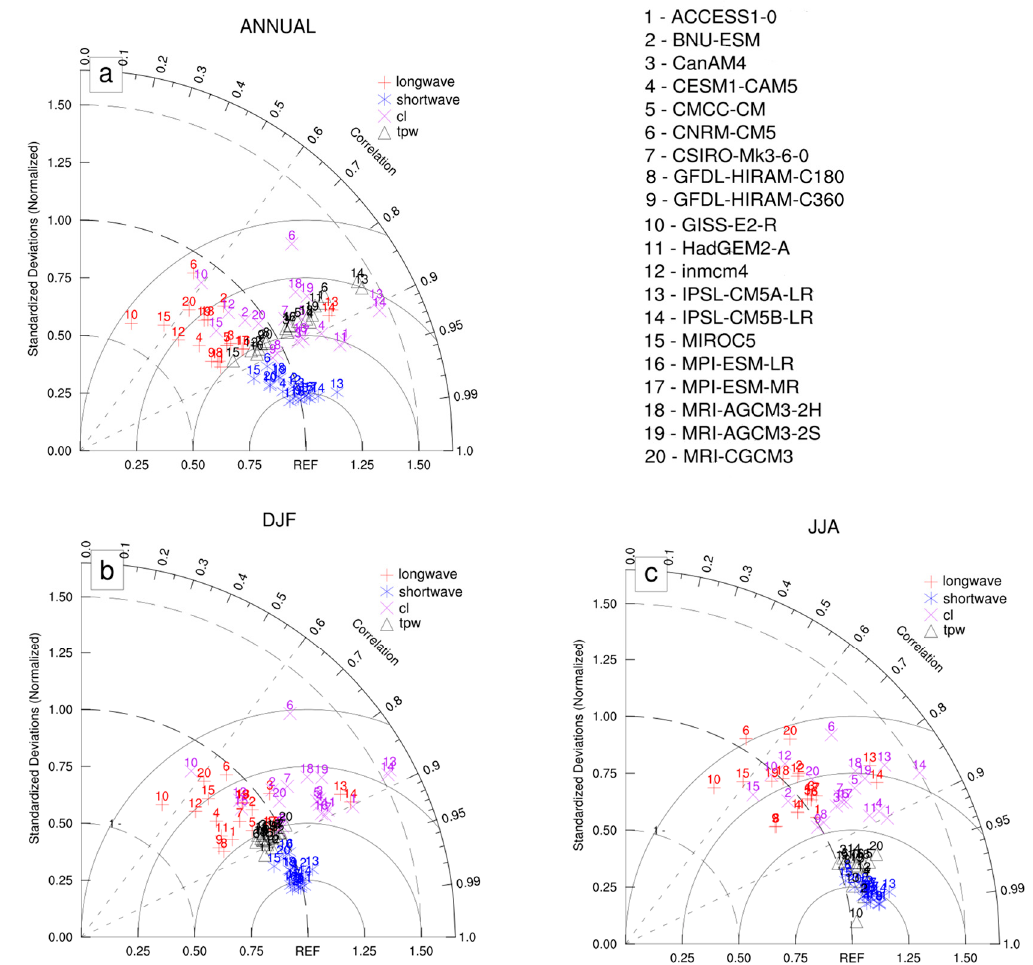
Figure 8. Taylor diagrams showing the ( a ) climatological and ( b , c ) seasonal (DJF and JJA) mean bias of Q LW and Q SW along with related variables including the total cloud cover (cl), and total precipitable water (TPW) simulated by 20 AMIP models compared to OAFlux from 1979 to 2000. The numbers 1 to 20 represent 20 AMIP